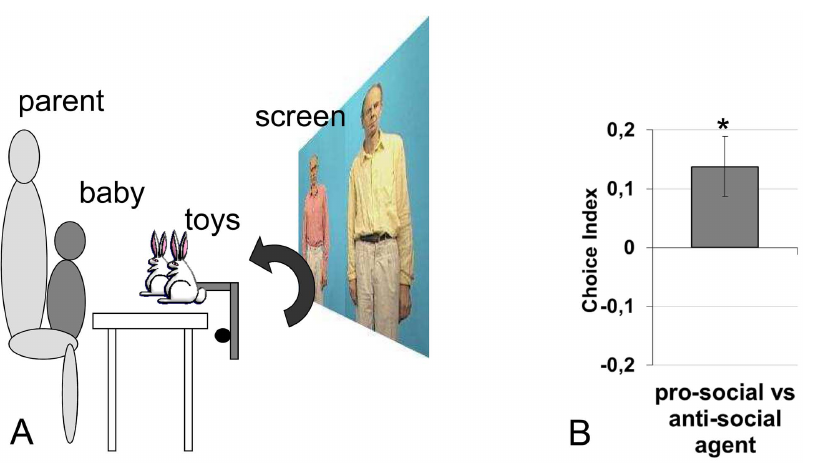
Figure 2. Set up and average preference index for 10-month-olds. A Setup of the experiment for the 10-month-olds. Infants are seated in their parent’s lap (who are blindfolded) during the experiment. After the presentation of the sequences described in Figure 1, infants see a novel sequence, where the two actors appear on stage, stare at the camera, play with two identical toys, and present them to the infants. Simultaneously, two real toys appear on the table through a mechanical device. The infants’ first attempt to reach one of the toys is coded by two independent scorers. Infants are tested 4 times with different toys, and the actors switching places on the screen. B. Average preference index for 10-month-olds computed over the 4 response trials. A positive score indicates a preference towards the toy of the pro-social agent, a negative score, a preference towards the anti-social agent. The error bars correspond to one between-subject standard error above and below the mean. *p , .05.